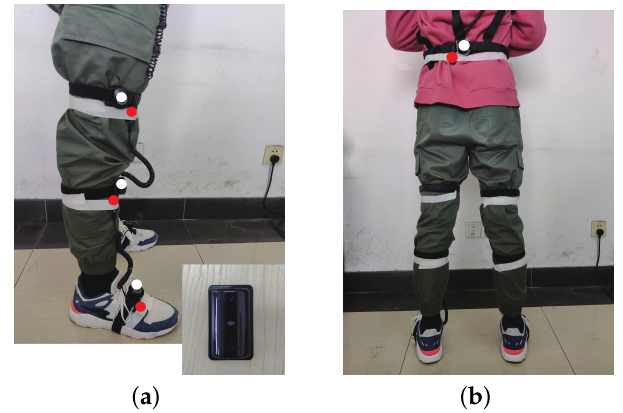
Figure 7. The motion capture test equipment. ( a ) he IMUs on the leg; ( b ) the IMUs on the